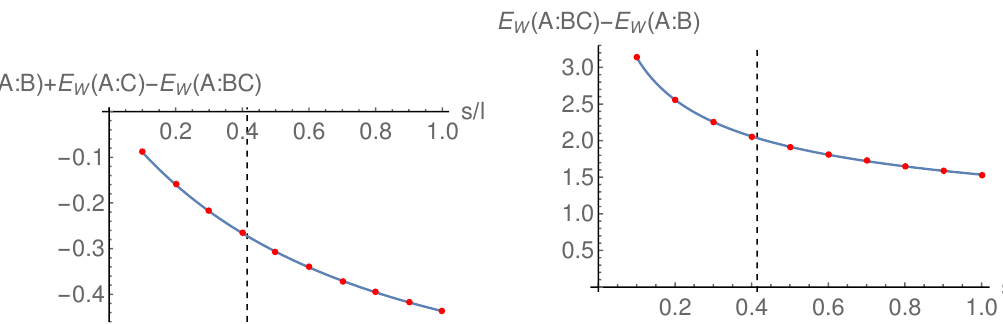
Figure 7 . Left : E W ( A : B ) + E W ( A : C ) − E W ( A : BC ) for different s/l ratios. Right : E W ( A : BC ) − E W ( A : B ) for different s/l ratios. For both the plots, analytic result is depicted by a solid curve and the numerical result is shown by red dots. Bipartite critical point at s/l ≈ 0 . 414 is indicated by a dashed